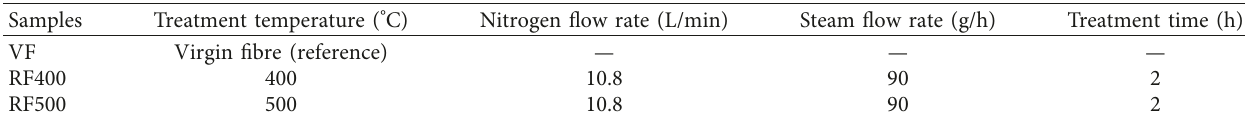
Table 1: Samples of the study and associated steam-thermolysis experimental conditions.